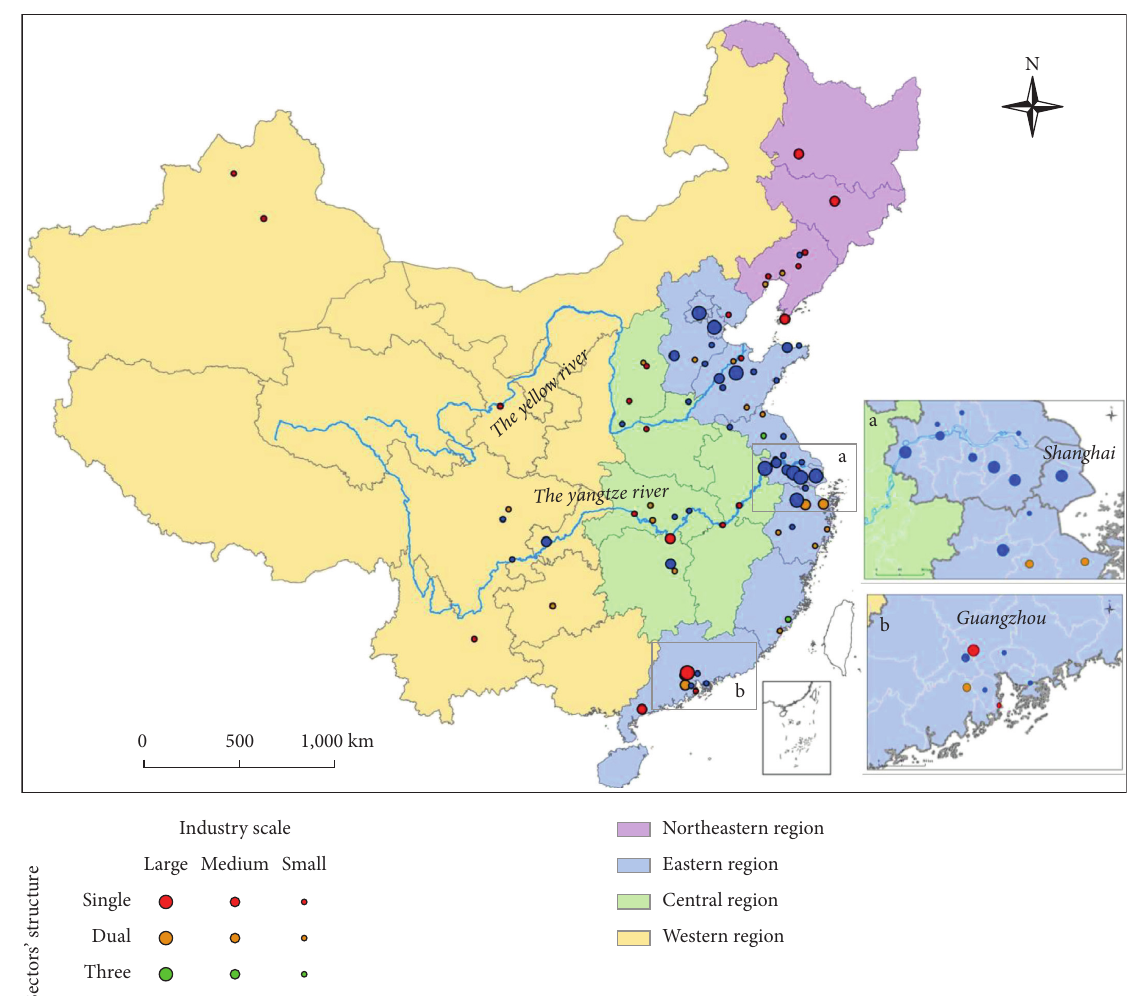
Figure 2: Spatial and type distribution of CICs in China,